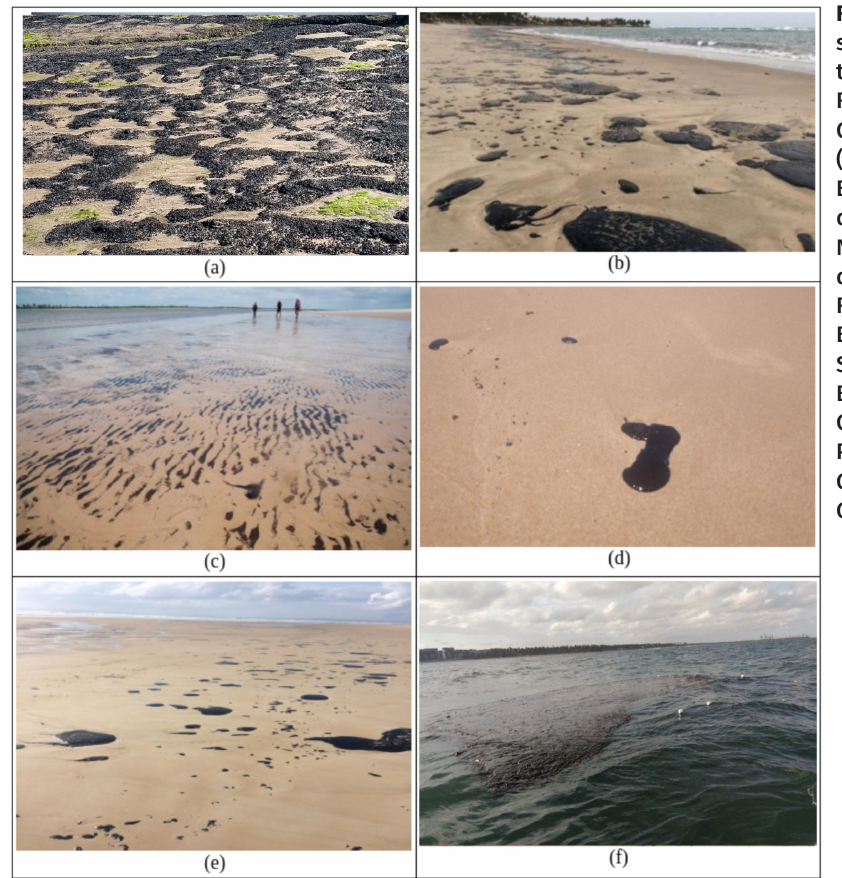
Figure 3. Examples of oil slicks found in the littoral